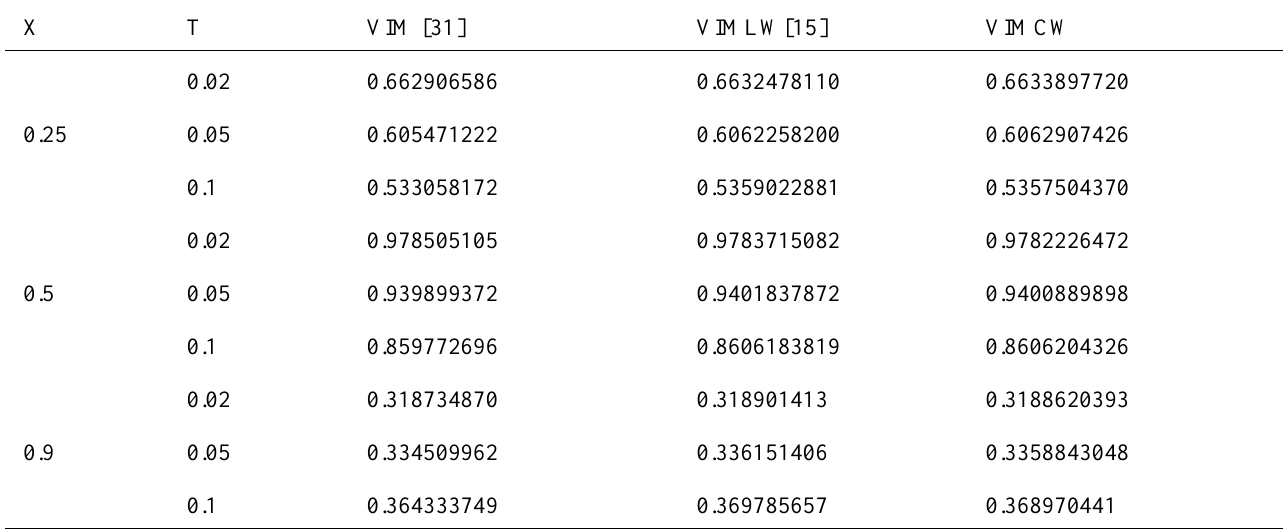
Effect of the Diffusion parameter on the solution, when α=β=γ=1and ε=0.1